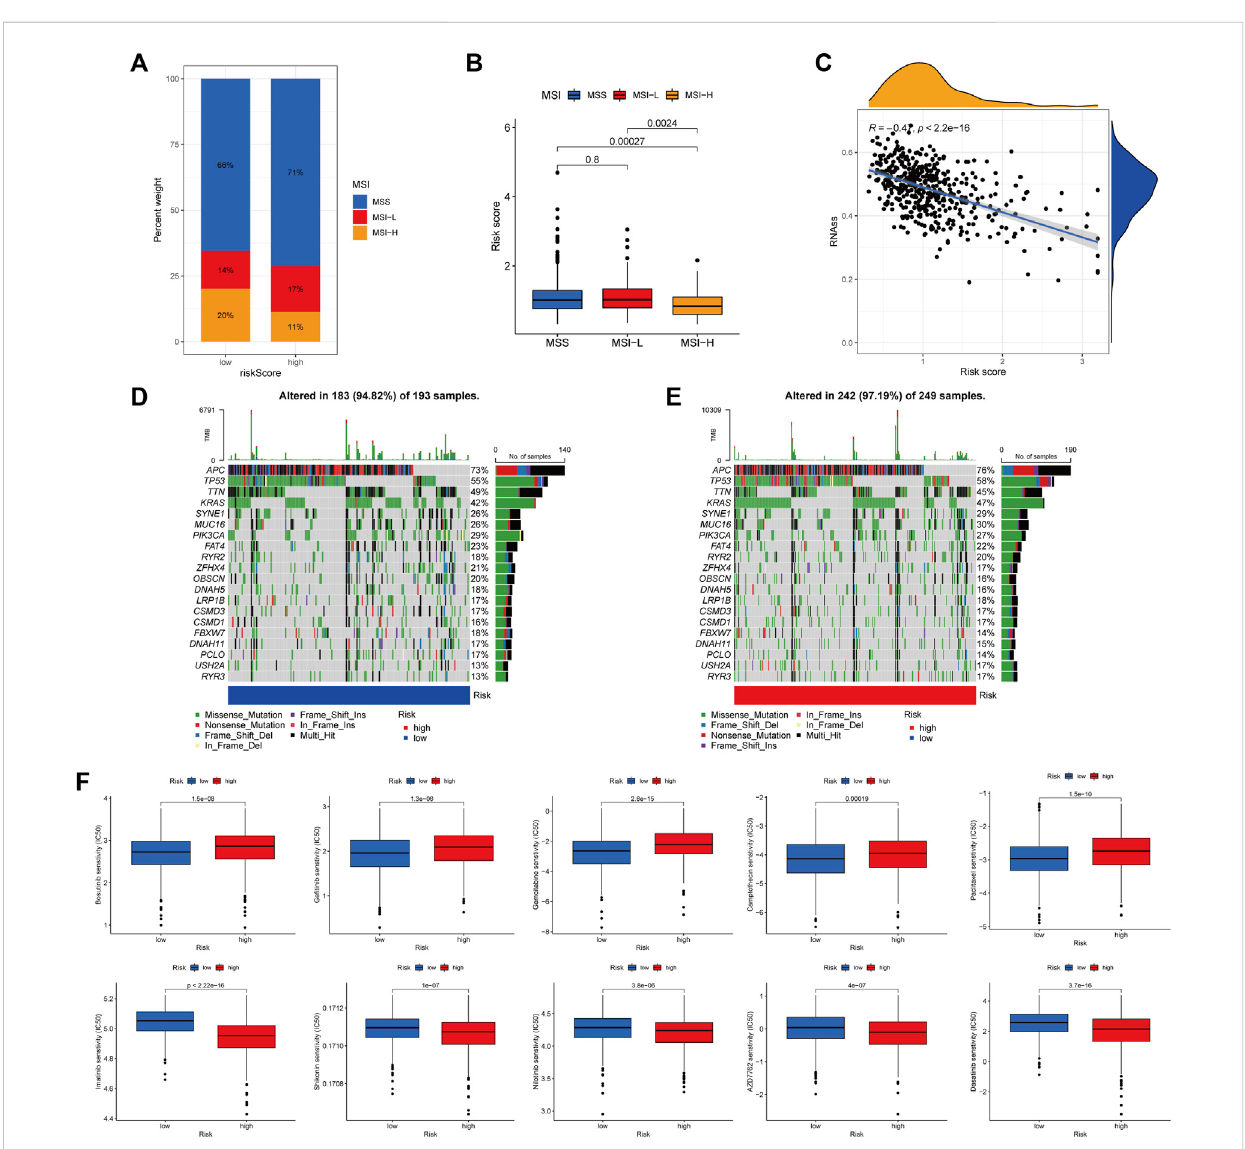
FIGURE 7 Comprehensive analysis of ARGscore in colorectal cancer. (A, B) Relationship between ARGscore and MSI. (C) Correlation between ARGscore and CSC index. (D, E) The waterfall plot of somatic mutation frequency was established on high and low ARGscore. The upper barplot showed TMB. The number on the right indicated the mutation frequency in each gene. The right barplot showed the proportion of each variant type. (F) Drug sensitivity analysis of ARGscore and chemotherapeutic